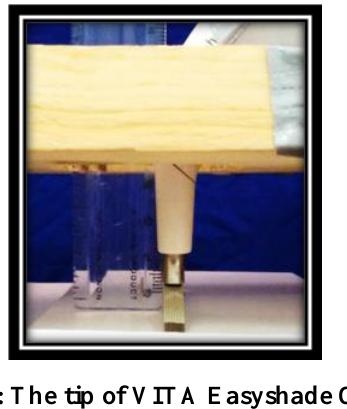
Fig. 4: The tip of VITA Easyshade Compact was perpendicular and in contact with archwires surface The color measurements were taken from twelve reference points which located at different distances from the beginning of the coating material and these points were recognized by permanent marker at the posterior surface of the sample. Five measurements of each reference point were performed and the average was calculated (4,5,9)